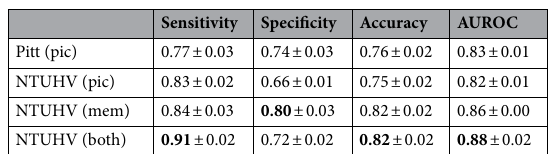
Table 7. Performance of MCI vs. HC on different datasets. Bold is used to highlight the highest value in each column.